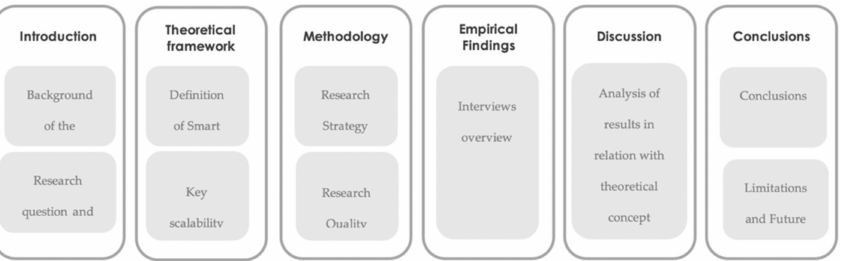
Figure 1. Research structure